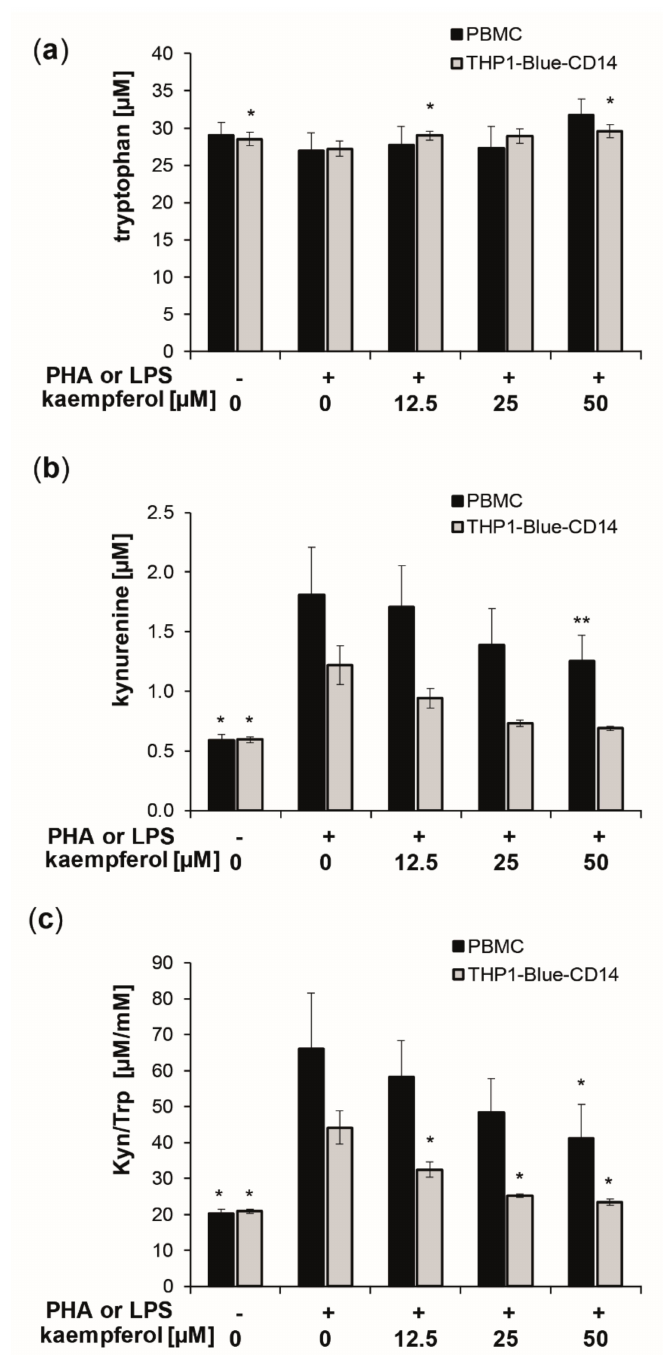
Figure2. Kaempferol treatment of phytohemagglutinin (PHA)[10 µ g / mL]-stimulated human peripheral blood mononuclear cells (PBMC) (black bars) and lipopolysaccharide (LPS) [100 ng / mL]-stimulated THP1-Blue-CD14 (grey bars). E ff ects on tryptophan (Trp) ( a ) and kynurenine (Kyn) ( b ) concentrations and the Kyn / Trp ratio, a measure of indoleamine 2,3-dioxygenase activity ( c ), was determined in cell culture supernatants after 24 h of incubation. Control cells received neither PHA, LPS, nor kaempferol. (Mean ± S.E.M, n = 5 for PBMC and n = 4 for THP1-Blue CD14, * p < 0.05, ** p < 0.005, compared to stimulated control